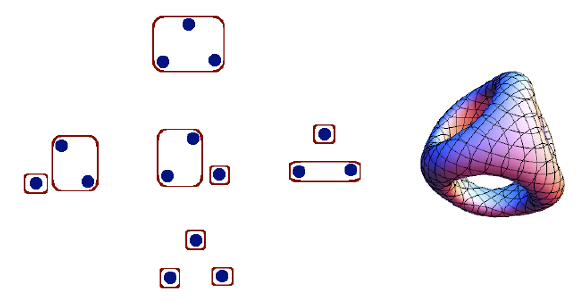
Figure 1 . Di(cid:11)erent types of multipartite entanglements and the higher genus toroidal represen-